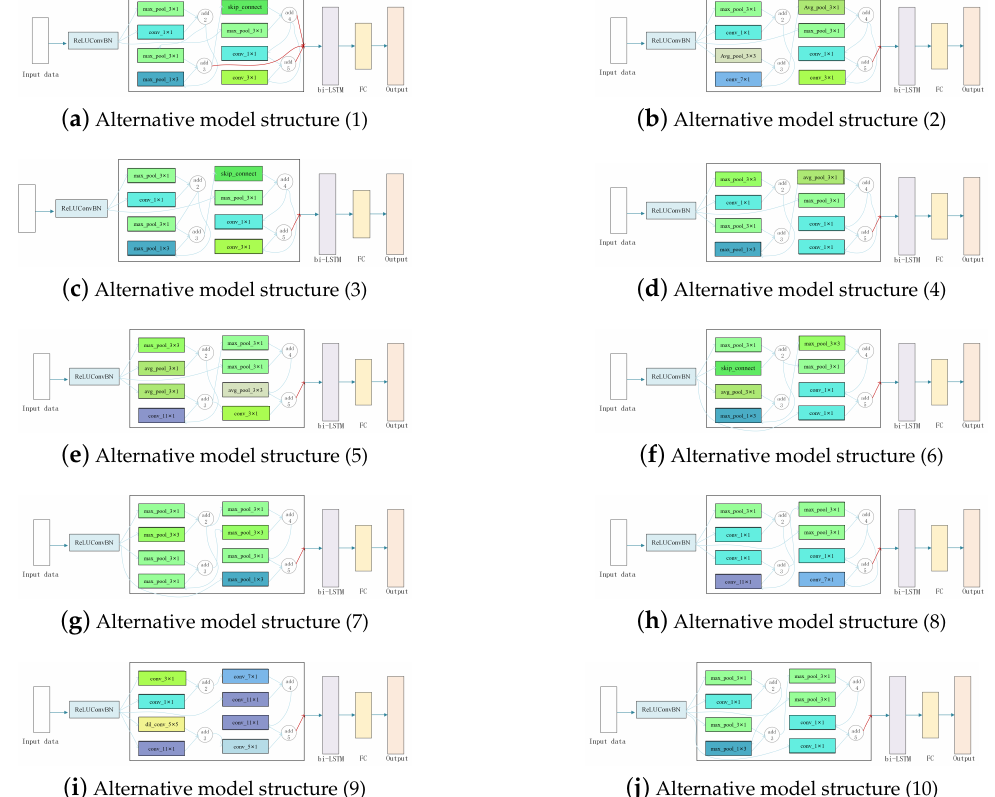
Figure 9. Set of network models searched on the Pareto frontier of UniMiB-SHAR.